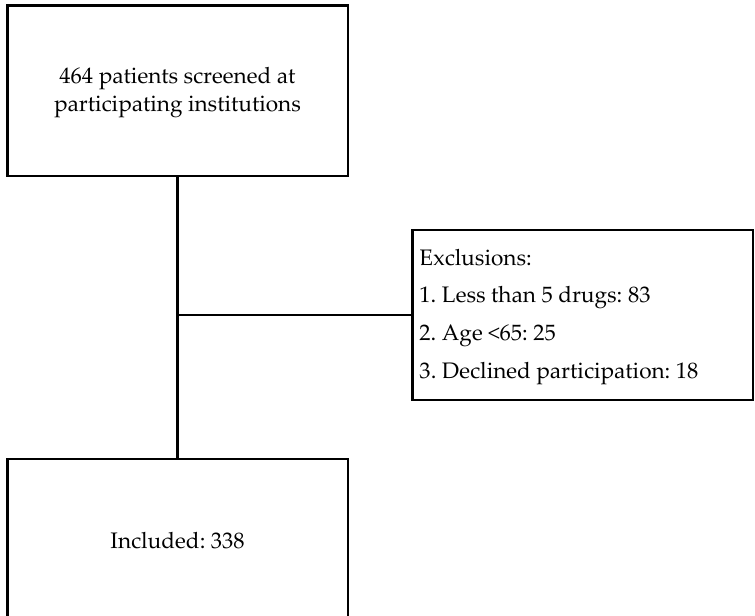
Figure 2. Flow-chart of screening, inclusion and exclusion of participants.